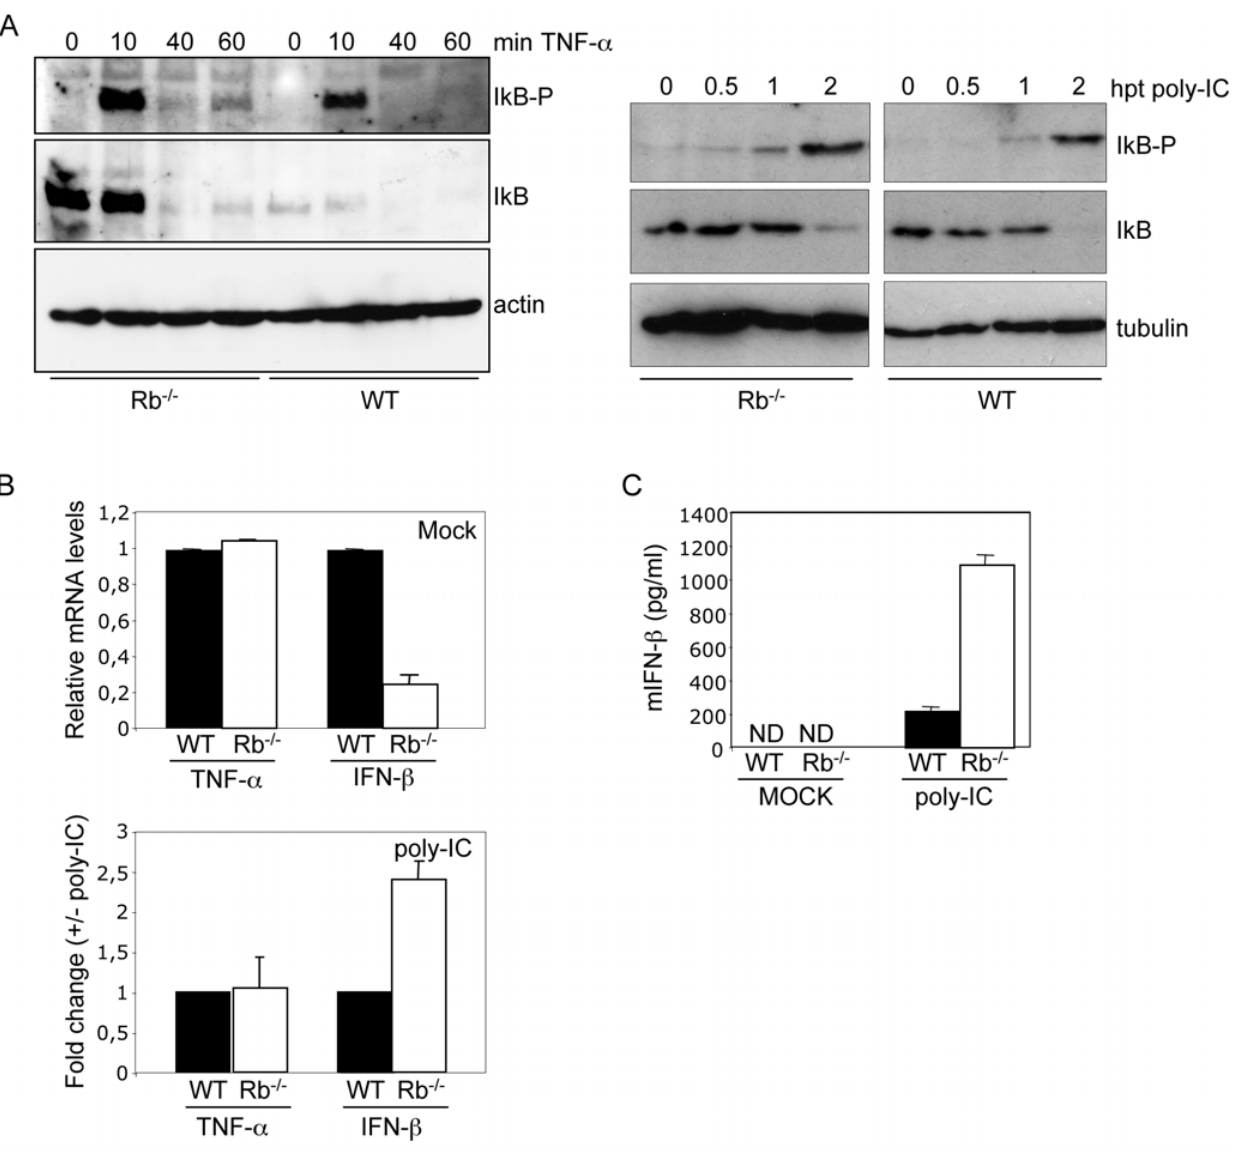
Figure 3. Rb-independent activation of NF-kB in response to TNF- a or poly-IC treatment. A, MEFs derived from WT or Rb 2 / 2 mice were treated with 20 ng/ml TNF- a (left panel) or transfected with poly-IC (right panel) and at the indicated times Western-blotting analysis of the indicated proteins was carried out. B, WT or Rb 2 / 2 MEFs were transfected with poly-IC and 4 h after transfection total RNA was isolated. After reverse transcription the samples were amplified by TaqMan-based QRT-PCR using taqman probes for TNF- a , IFN- b , and GADPH and analyzed. The expression levels were determined relative to GADPH and represented as fold change in Rb 2 / 2 relative to the expression detected in WT cells. C, WT or Rb 2 / 2 MEFs were transfected with poly-IC and 8 h after transfection IFN- b production in the cell culture supernatants was measured by ELISA. Error bars indicate mean + / 2 SE. ND, not detected.